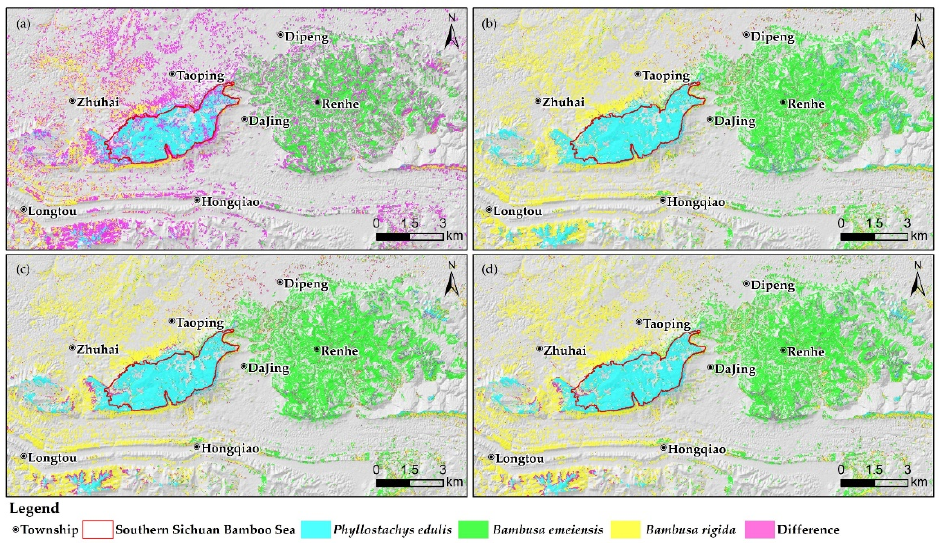
Figure 12. Comparison of differences in classification maps: ( a ) SAM vs. XGBoost (important and uncorrelated variables), ( b ) XGBoost (all variables) vs. XGBoost (important variables), ( c ) XGBoost (all variables) vs. XGBoost (important and uncorrelated variables), and ( d ) XGBoost (important variables) vs. XGBoost (important and uncorrelated variables).